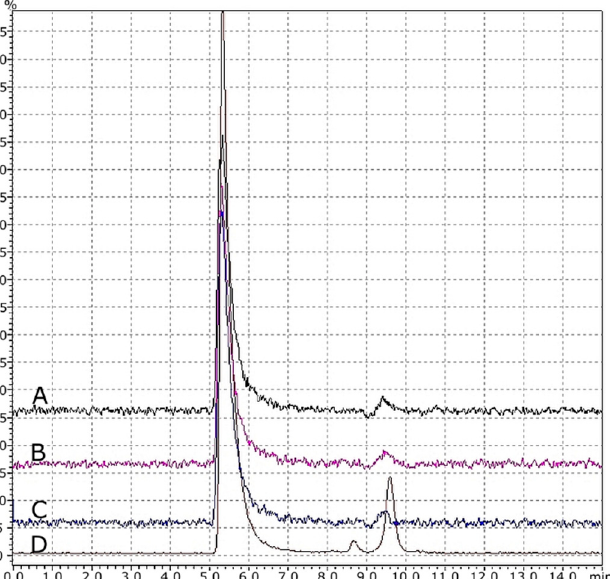
Figure 10. GPC chromatograms: A = printout, B = string, C = modified granules and D = pure PC granules.